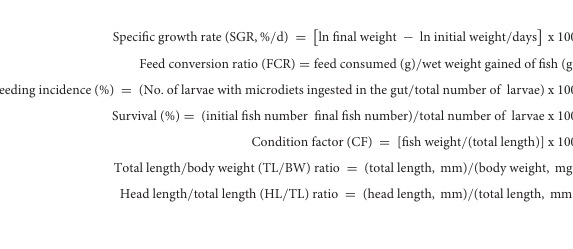
Table 2 . The final body weight, final TL, and SGR of fish-fed palm oil-based microdiets were significantly higher than the